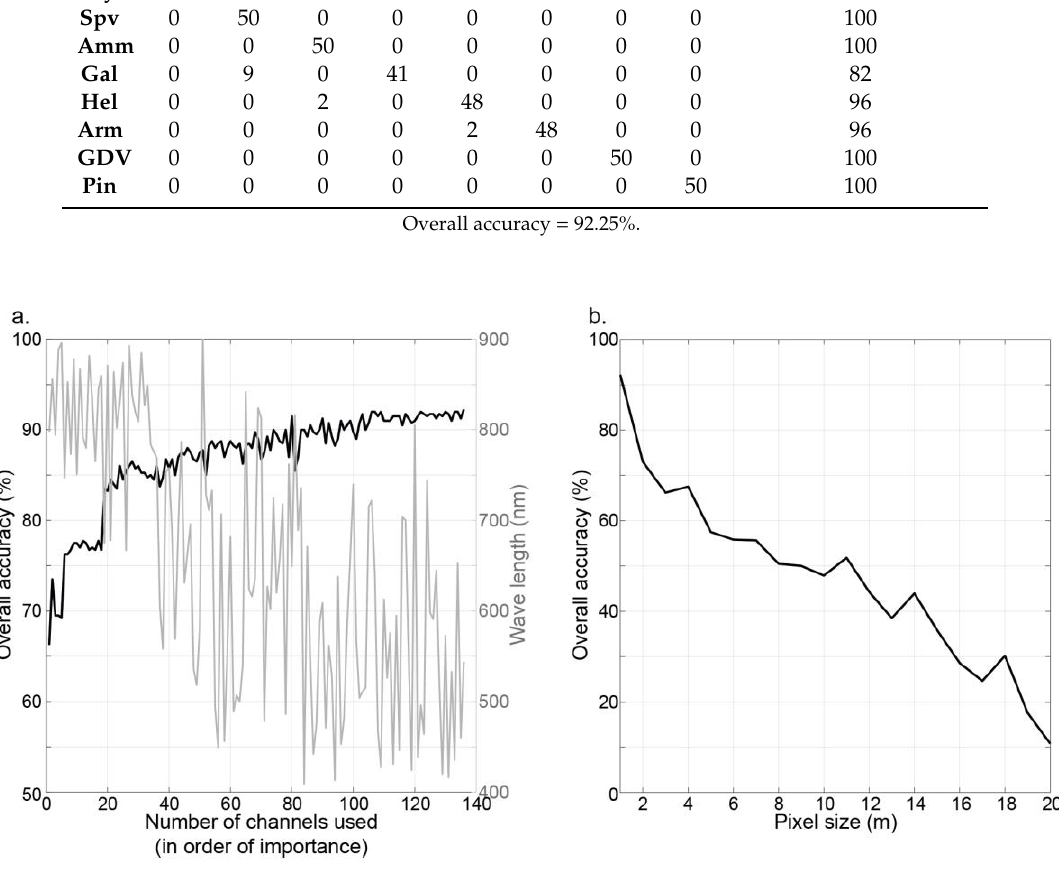
Figure 8. ( a ) Evolution of the overall accuracy (left axis) for the vegetation class and the selected wavelength (right axis) as a function of the number of channels used in the RF classifier (classed in order of importance according to their mean decrease in the Gini index) and ( b ) evolution of the overall accuracy as a function of the pixel size for the vegetation